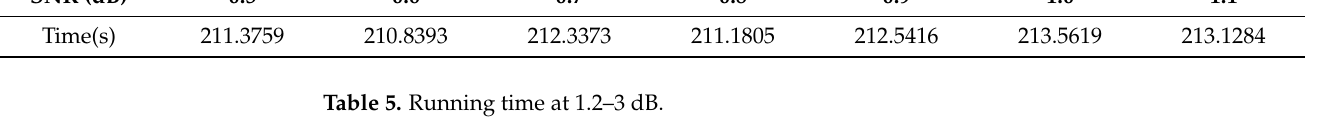
Table 5. Running time at 1.2–3